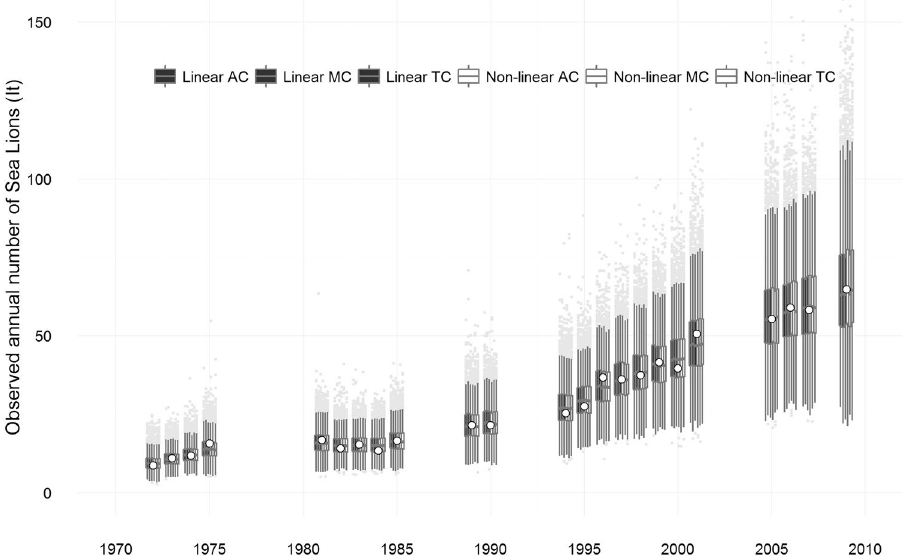
Figure 2. Trend of observed annual number of South American sea lion Otaria flavescens . Time series of observed annual number (white dots), together with posterior medians (horizontal dashes in boxes), first and third quartiles (boxes), and 2.5/97.5 percentiles (whiskers), provided by (from left to right) the linear and non- linear density-dependence models ( I t ) according to the three bycatch estimated series. TC: Total Catch set; AC: Average Catch set; MC: Maximum Catch